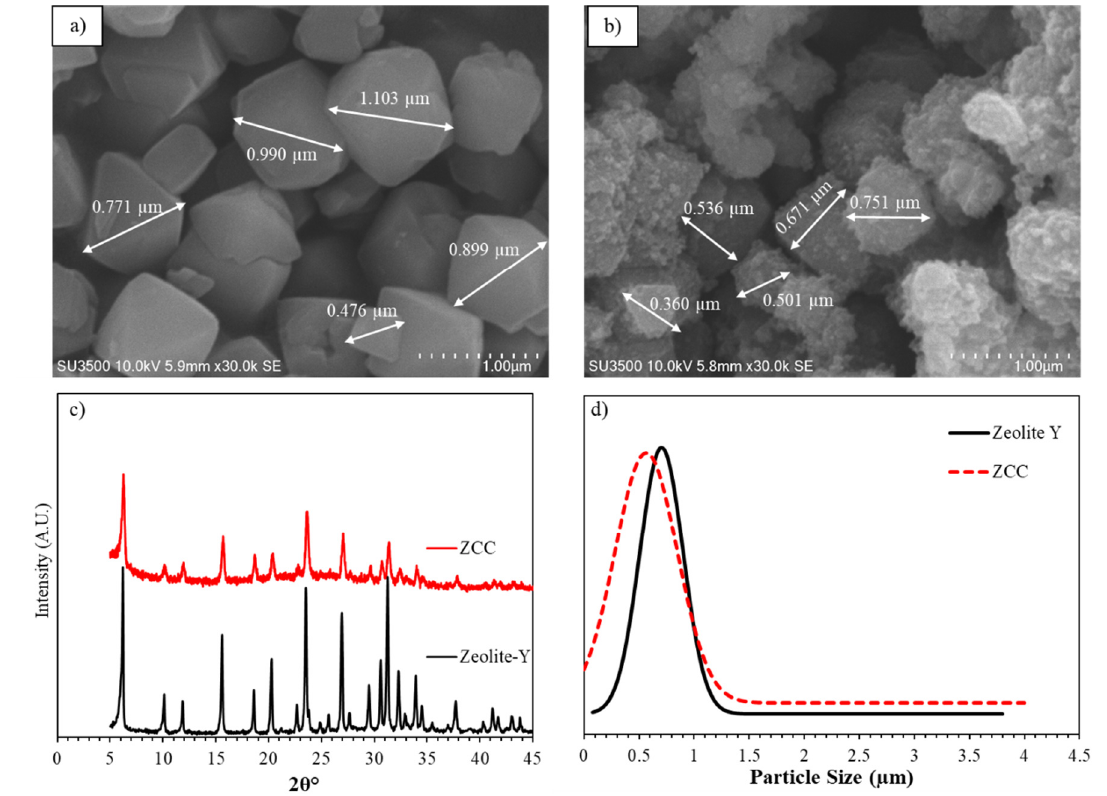
Figure 1. SEM images of ( a ) zeolite-Y and ( b ) zeolite carbon composite (ZCC) SEM; ( c ) X-ray diffractograms of zeolite-Y and ZCC; ( d ) particle size distribution of zeolite-Y and ZCC.